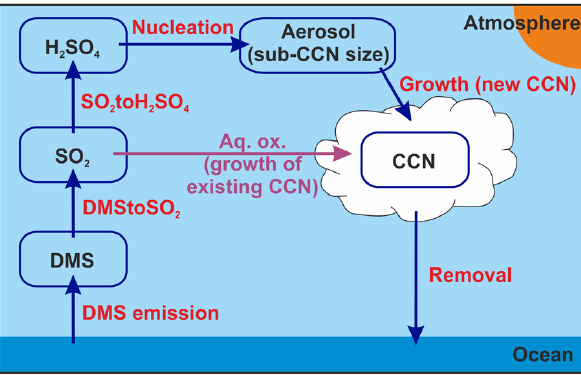
Fig. 5. Schematic indicating the processes through which DMS- derived sulphur can form new CCN. The aqueous-phase oxidation process is also included (highlighted in purple), despite not forming new